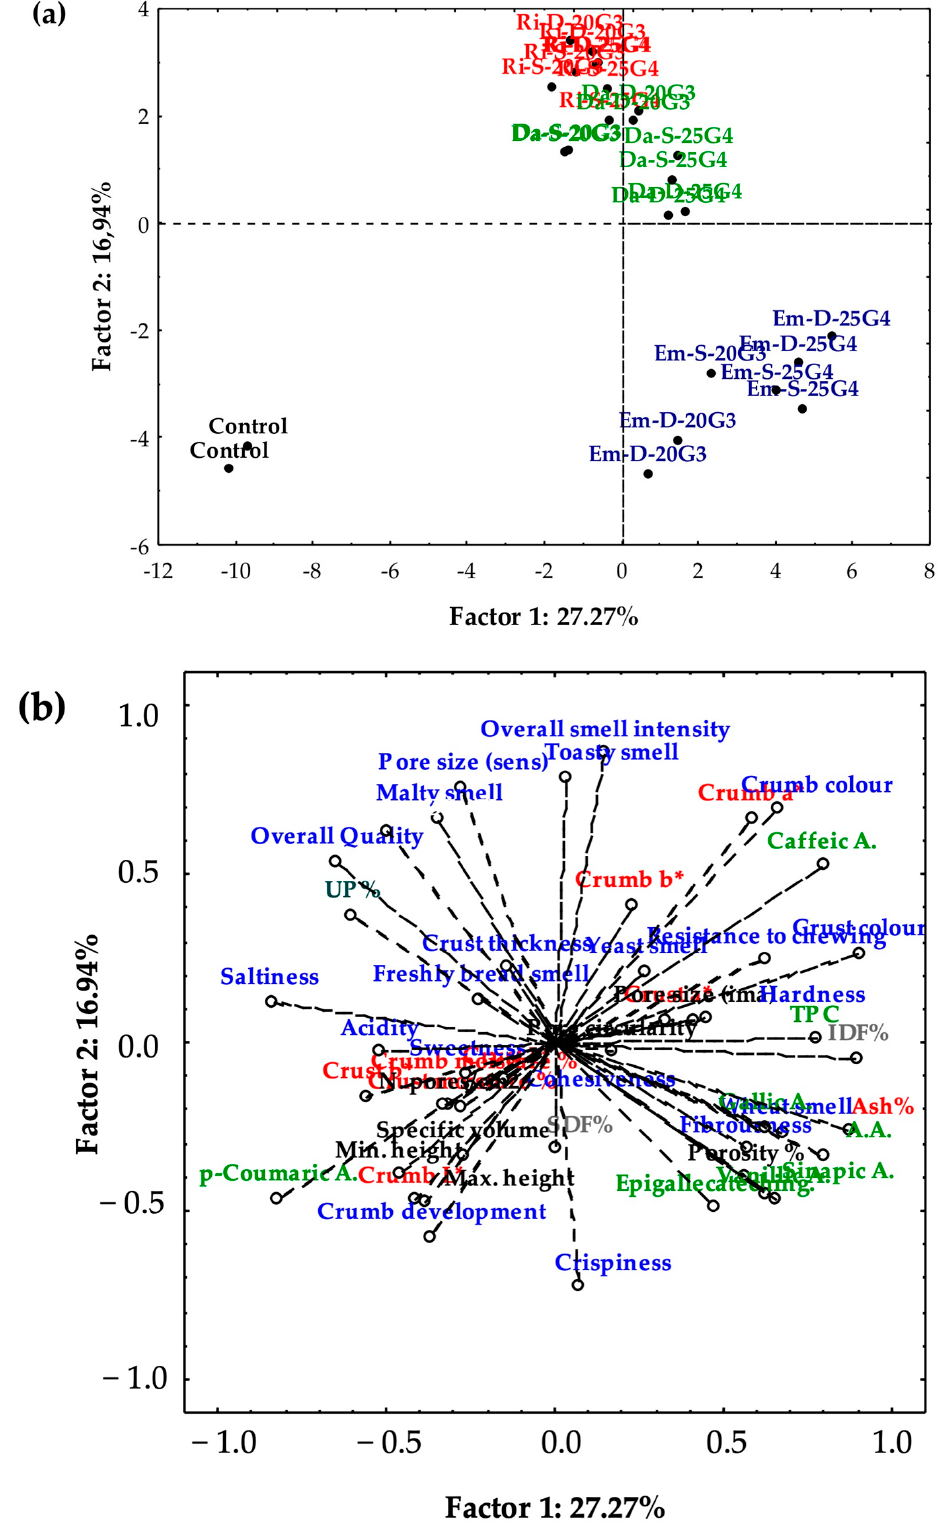
Figure 4. Projections of ( a ) control and functional breads and ( b ) the related experimental data on the factorial plane. Phenolics are in green font; Insoluble and Soluble Dietary Fibres are in purple; UP% is in dark green; Moisture %, Ash %, and colorimetric indices are in red; structural parameters are in black.